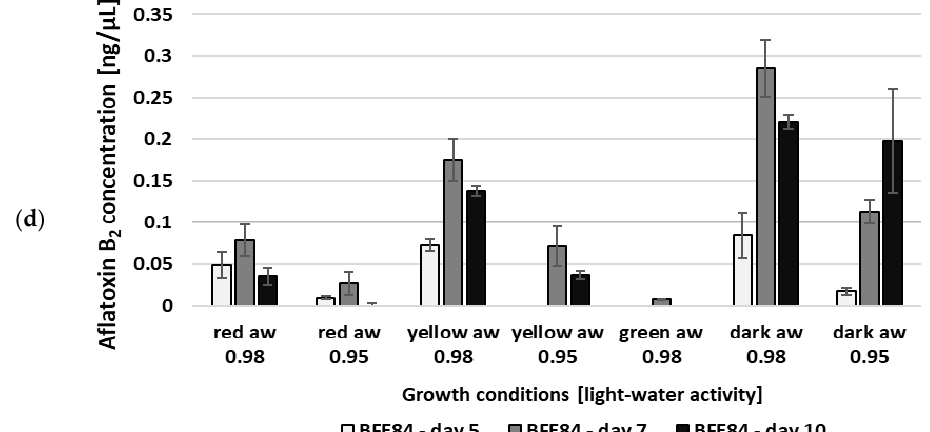
Figure 2. Aflatoxin B 1 ( a ) and B 2 ( b ) formation by Aspergillus flavus MRI19; aflatoxin B 1 ( c ) and B 2 ( d ) formation by Aspergillus parasiticus BFE84, dependent on different combinations of light and water activity. No aflatoxin was detectable in the case of A. parasiticus BFE84 under white light, a w 0.98 and a w 0.95; green light and a w 0.95; and blue/royal blue light. Standard deviations are given for each parameter. * = The toxin production was significantly reduced in relation to the control (dark). For B 2 -aflatoxins the measured values were too low for statistical significance analysis.